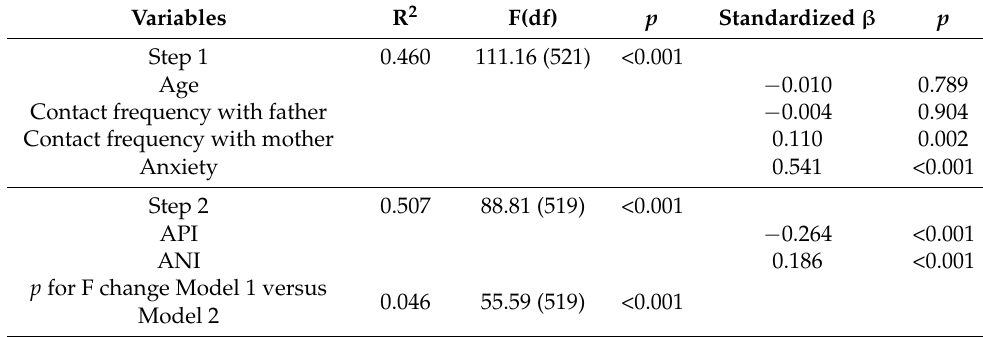
Table 4. Hierarchical multiple regression analyses for depression in boys ( n =